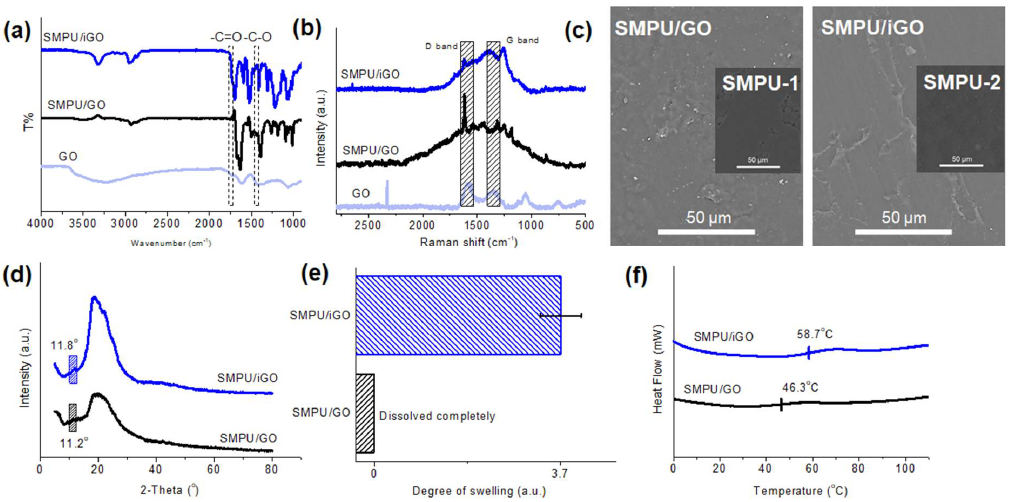
Figure 2. Characterization of the SMPU / iGO and SMPU / GO composites: ( a ) Fourier transform infrared (FTIR) spectra, in which the gray area indicates the bands at 1740 cm −1 and 1060 cm −1 ; ( b ) Raman spectra, in which the gray area indicates the D bands and G bands ; ( c ) morphologies, in which the inserts are the SEM images of their own SMPU matrix — SMPU-1 for the SMPU / GO and SMPU-2 for the SMPU / iGO; ( d ) XRD results; ( e ) swelling degree; and ( f ) differential scanning calorimetry (DSC) results.